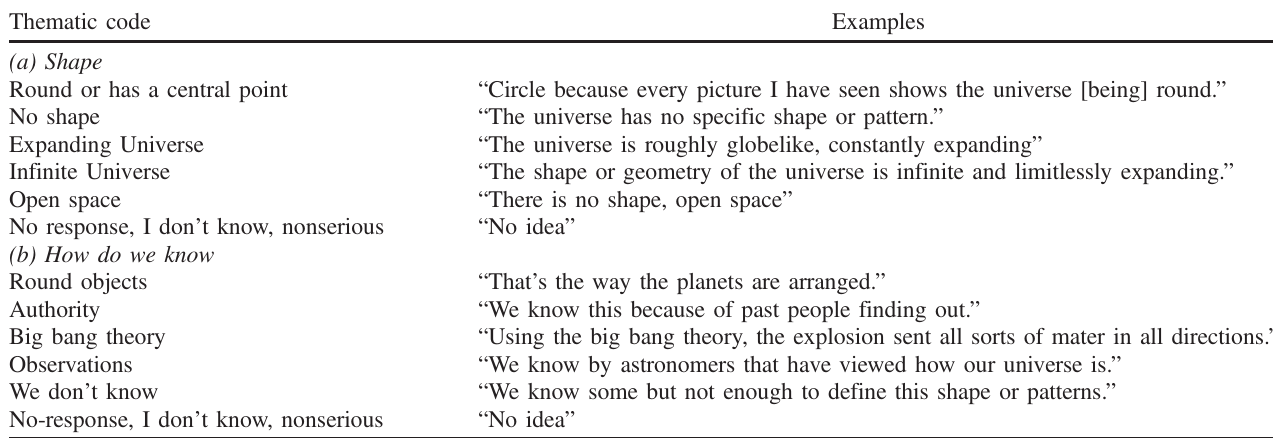
TABLE V. Thematic coding scheme for preinstruction survey question 1.